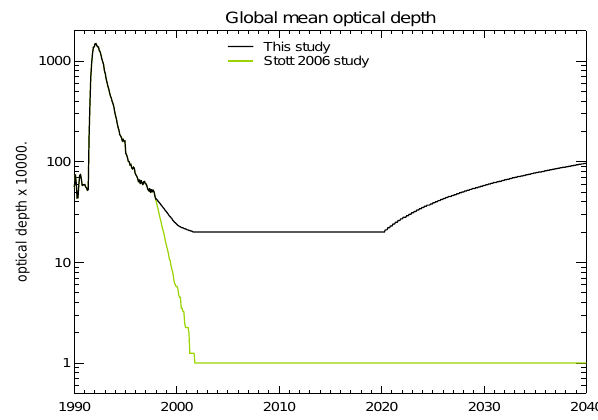
Fig. 14. Monthly global mean stratospheric optical depth as used in this study and what was included in the HadGEM1 simulations (Stott, 2006), for the period